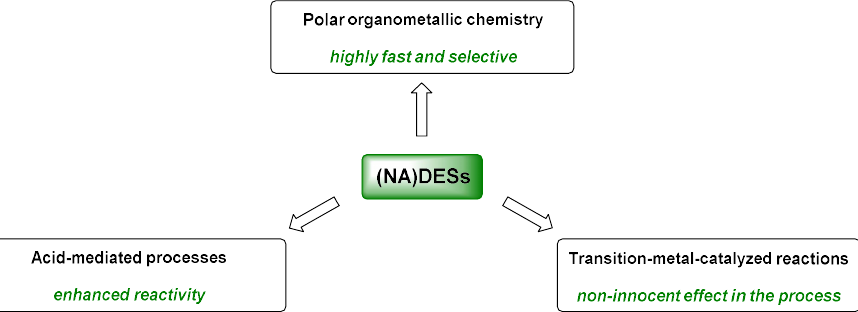
Figure 4. Fields of the most recent applications of DESs as solvents or co-catalysts in organic transformations.